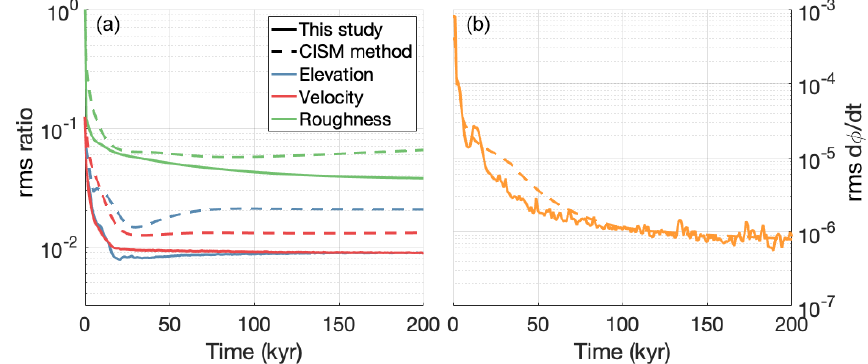
Figure A1. Convergence of the inversion procedure for experiment I. (a) Root mean square of the relative mismatches in surface elevation (blue), surface velocity (red), and bed roughness (green) over time, for both the flowline-averaged method presented here (solid lines) and the local-mismatch approach from CISM (dashed lines). (b) Root mean square of the bed roughness rate of change, for both methods.